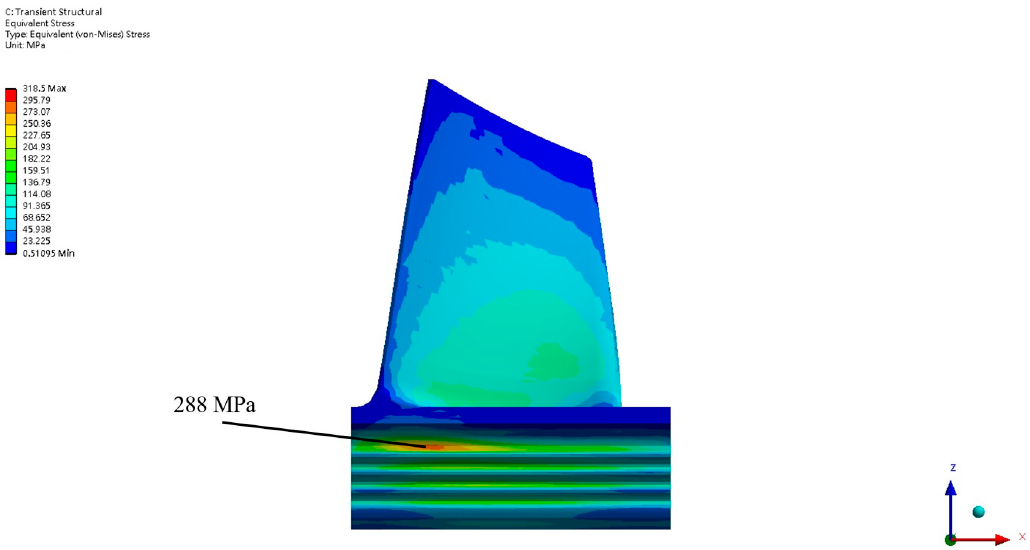
Figure 22. The stress distribution of the 1st stage blade.